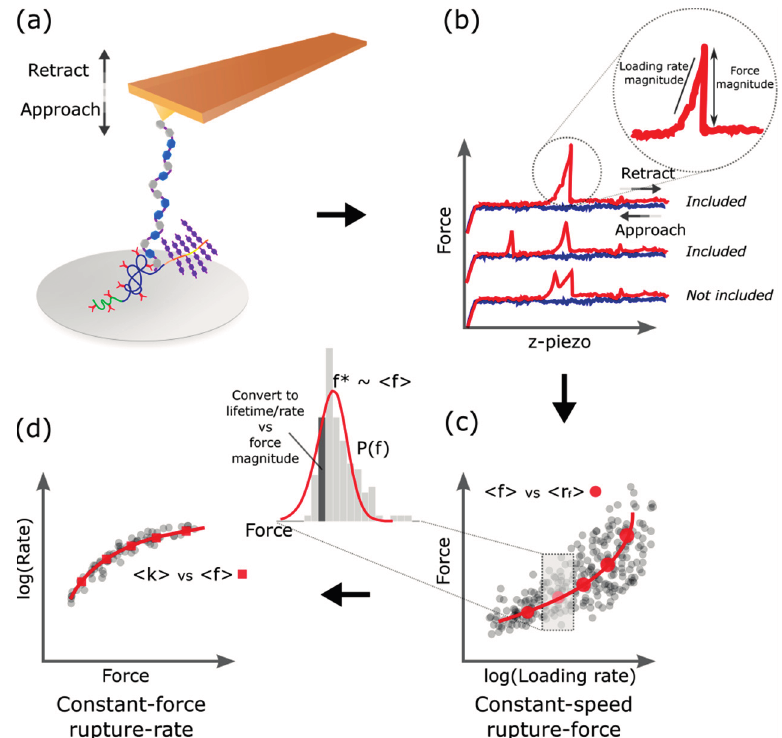
Figure 1. A schematic illustration of the data collection and analysis for the forced-unbinding study of chitosan–mucin and alginate–mucin. ( a ) An AFM-cantilever with peptide-bond anchored chitosan/alginate was extended to a mica slide with peptide-bond anchored mucin and subsequently retracted; ( b ) Illustrations of typical interaction curves obtained from the AFM experiments; ( c , d ) The unbinding forces with corresponding loading rates were analyzed as outlined in the experimental section, to yield estimates of parameters x β , τ 0 and Δ G of the interaction . Symbols included in the graph are explained